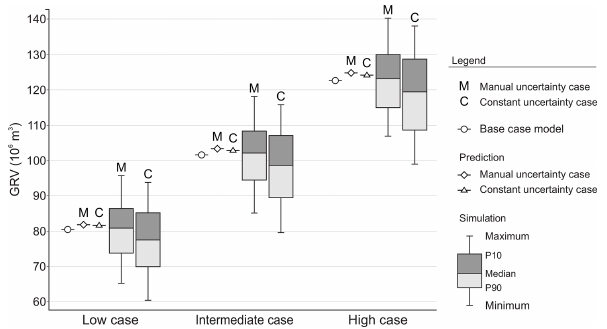
Figure 11. Box plots of the GRV obtained from the 200 realiza- tions (simulation method) of the manual and the constant uncer- tainty cases for the low, intermediate and high oil–water contact depths. The GRVs of the base case and prediction models are also